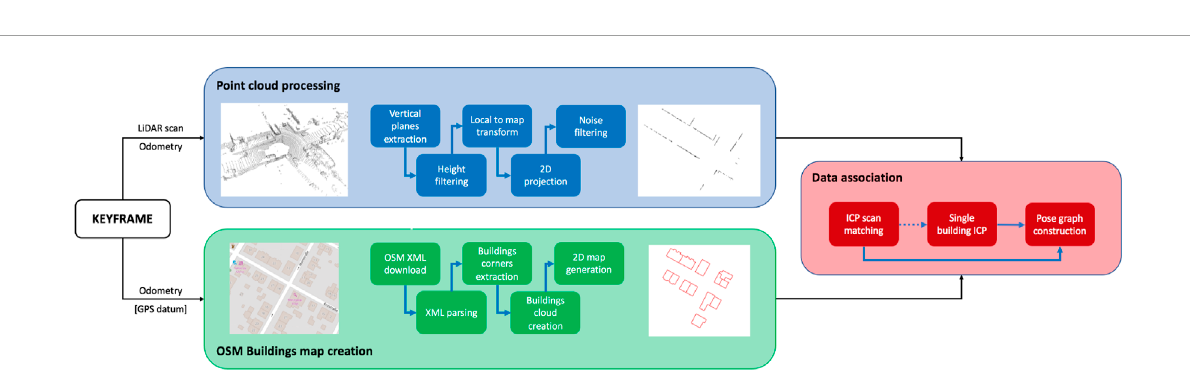
FIGURE 1 Architecture of the proposed system. The majority of core modules come from ART-SLAM Frosi and Matteucci (2022), while our improvements can be found in the pose graph builder, and in the new module OSM MAP BUILDER , which handles OpenStreetMaps data.